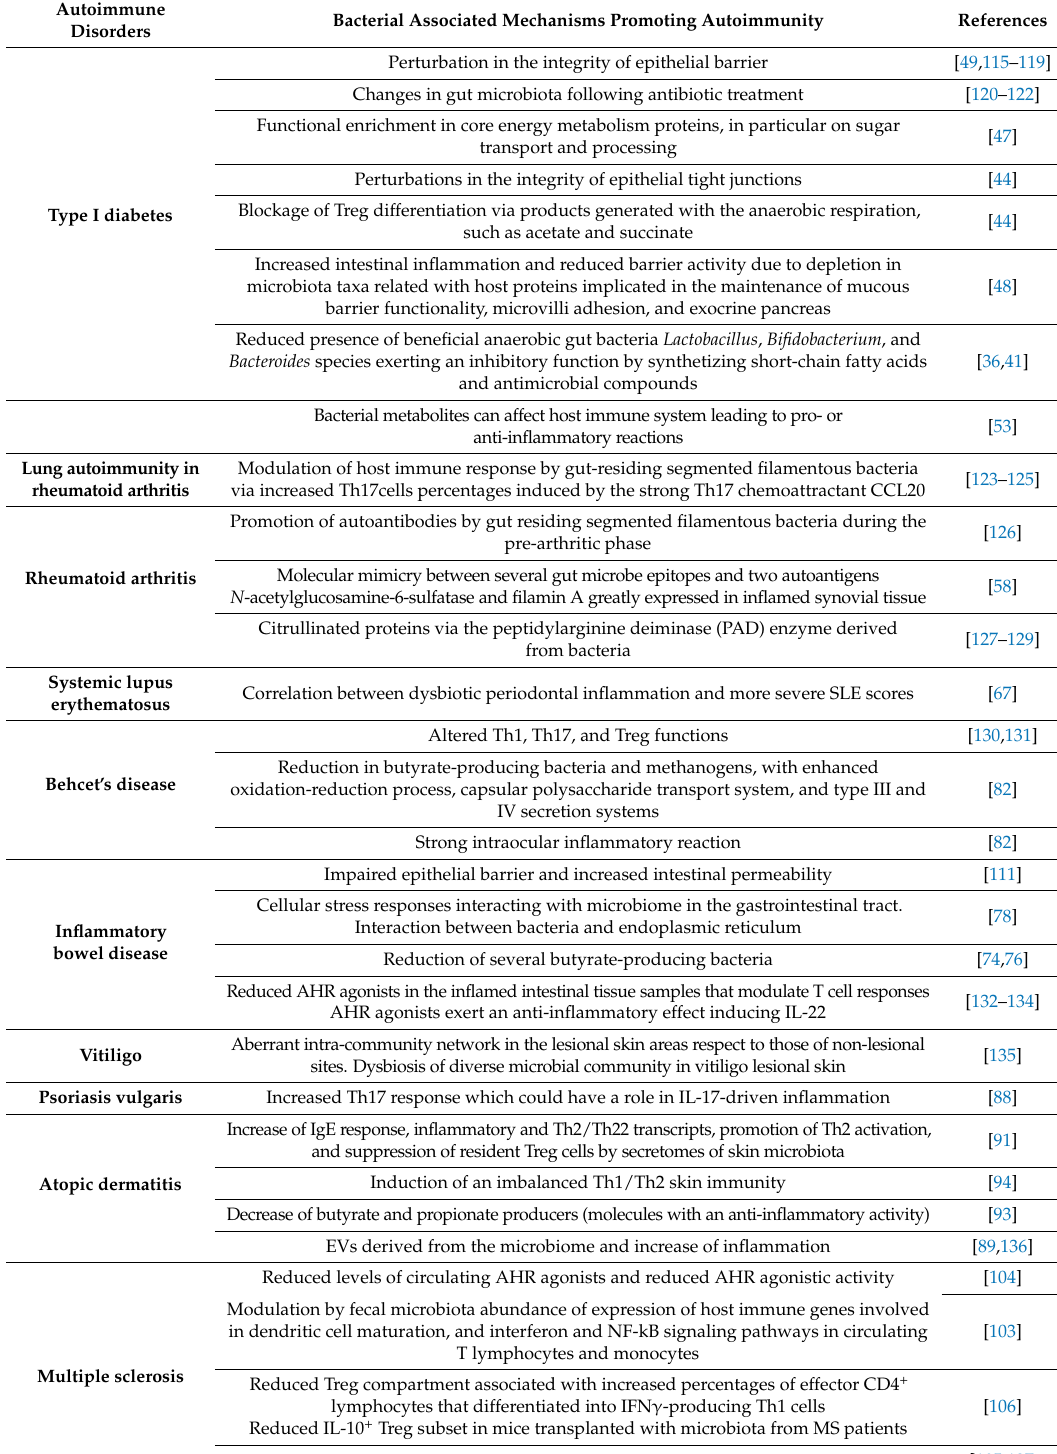
Table 2. Bacterial associated mechanisms promoting